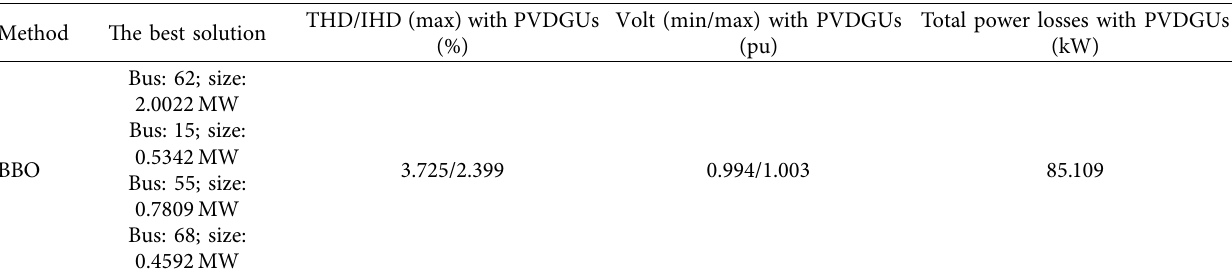
Table 18: The best solutions and the total capacity of PVDGUs found by nine implemented methods for the IEEE 69-bus distribution network in Case